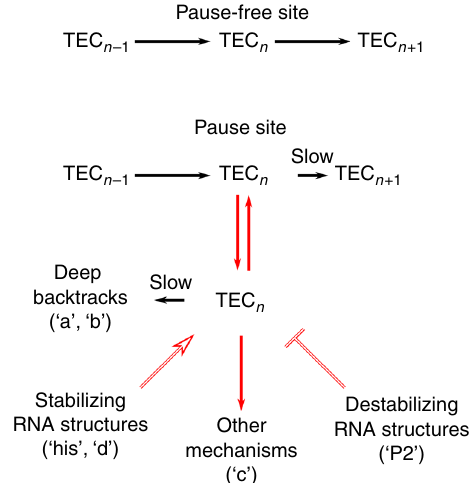
Fig. 6 Proposed model for transcriptional pausing by E. coli RNAP. TEC: Transcription Elongation Complex; the indices n − 1, n , and n + 1 indicate the length of the RNA product. At pause sites, the paused state is rendered kinetically accessible to the polymerase through a slowing down of the on- pathway forward translocation rate. Depending on the sequence context, this paused state can transition slowly to a ≥ 2 bp backtracked state (in sites ‘ a ’ and ‘ b ’ ), be stabilized or destabilized by the nascent RNA ( ‘ his ’ , ‘ d ’ , and ‘ P2 ’ ) or be stabilized by other mechanisms (such as in site ‘ c ’ , which exhibited neither backtracking nor RNase